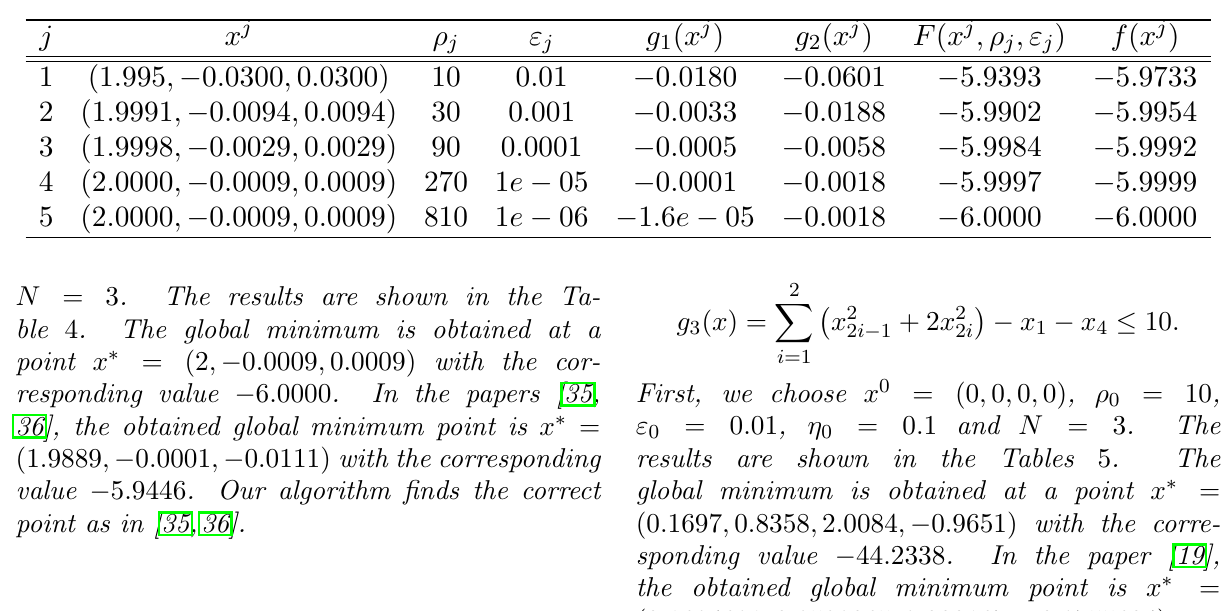
Table 4. Table of minimization process of the Problem